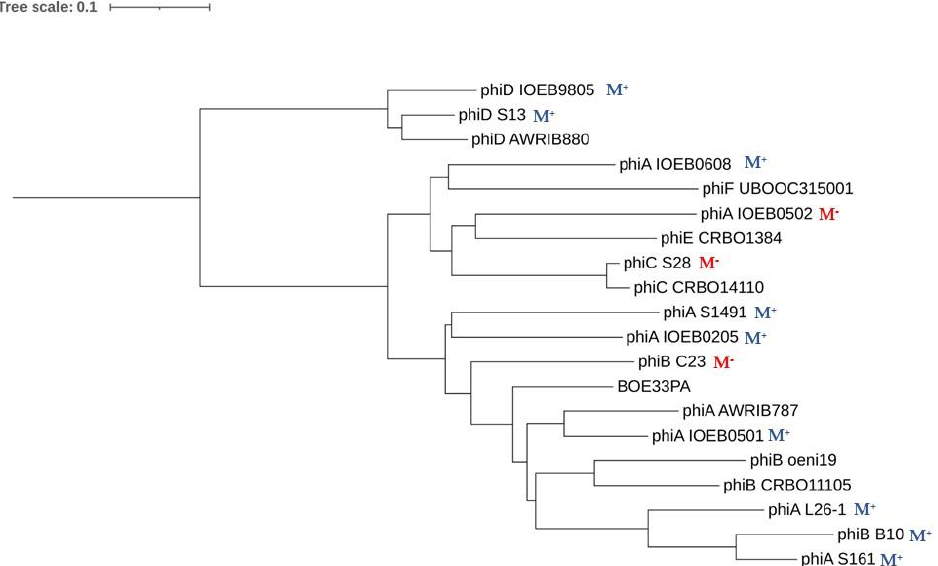
Figure 6. Phylogenomic Genome BLAST Distance Phylogeny (GBDP) tree of representative oenophages from the CRB Oeno Collection. The tree was generated by VICTOR and visualized with Fig Tree [36]. Int groups are represented by letters (A to F). B10 is the prophage found in strain IOEB B10. M + and M − indicate the presence or absence of (i) a lysis when the lysogen was grown in the presence of mitomycin C and (ii) plaques when the MC lysate was tested on the sensitive strain IOEB S77.